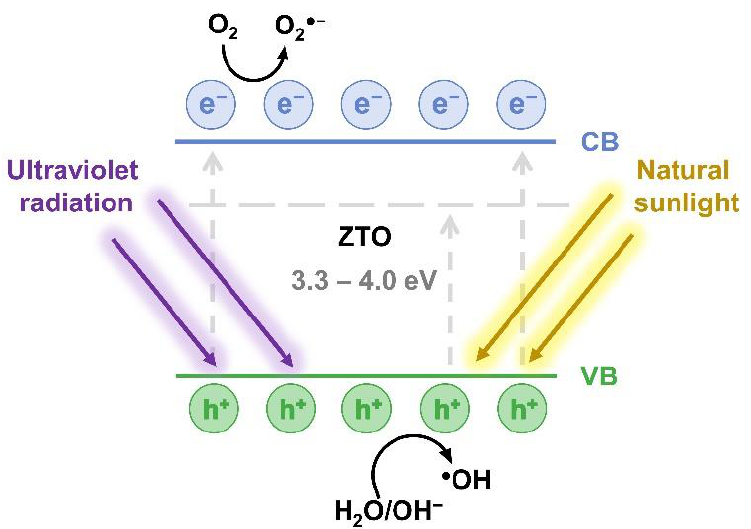
Figure 1. Representative schematic of the photocatalytic mechanism of ZTO nanomaterials.